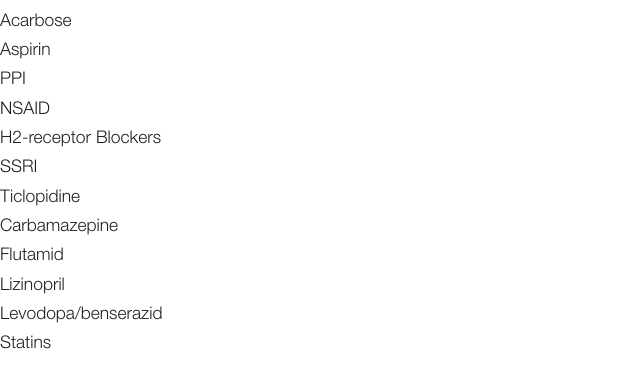
TABLE 2 | Drugs increasing the risk of MC.